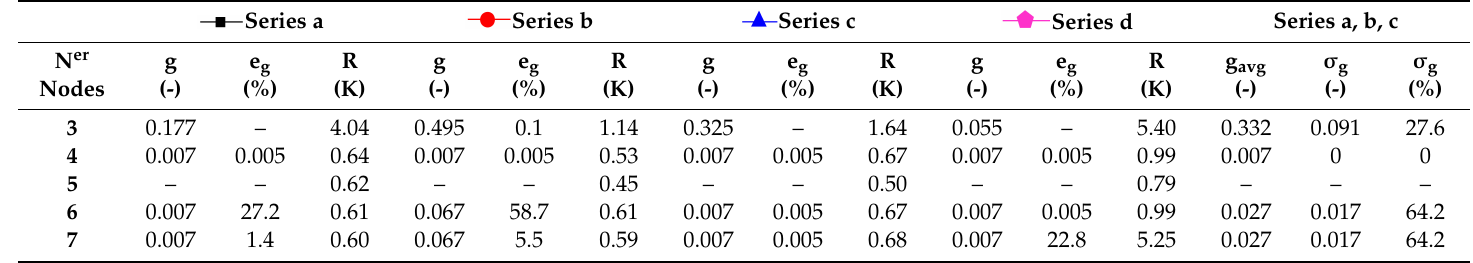
Table 4. Ceiling. g value. Summary of the results using models that include solar radiation. Output: T i . Where e g is the error and R is the average of the residuals given by LORD for each data